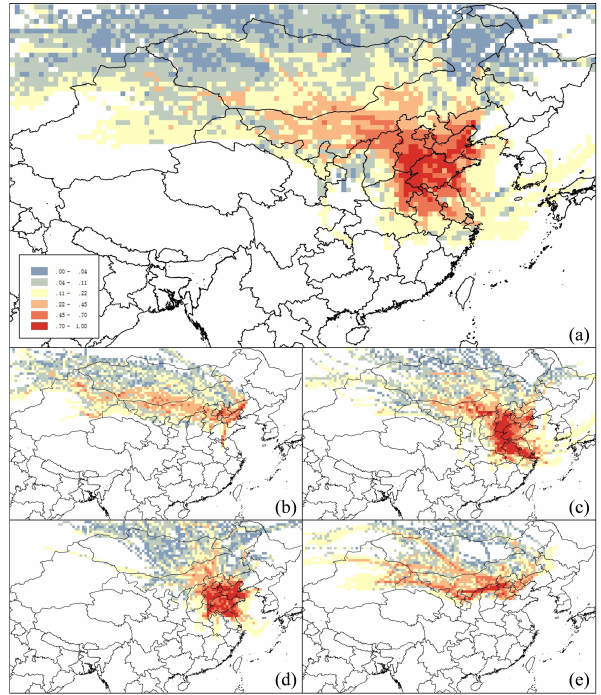
Fig. 11. Spatial contribution of mercury emission sources simulated by PSCF model (a) overall, (b) winter, (c) spring, (d) summer, (e)